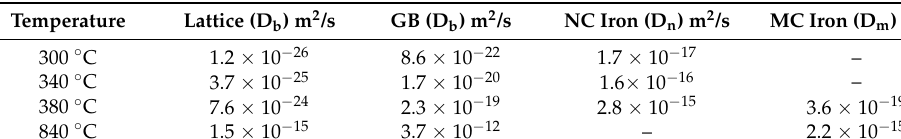
Table 1. Diffusion coefficients of Cr in NC and MC iron [31].